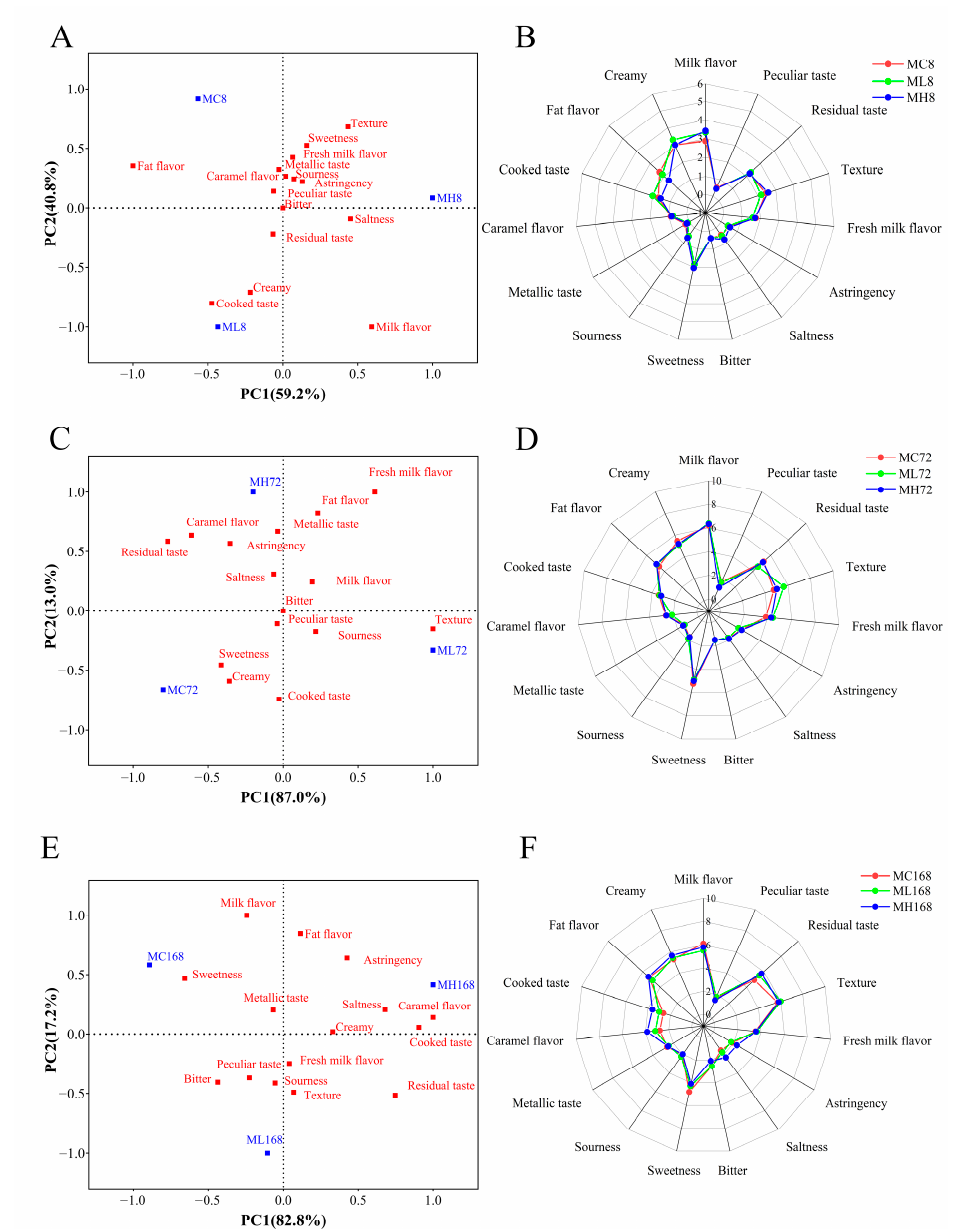
Figure 4. Principal component Analysis (PCA) diagram and spider web diagram of pasteurized milk. MC, 0-bar pressure-homogenized pasteurized milk; ML, 150-bar pressure-homogenized pasteurized milk; and MH, 300-bar pressure-homogenized pasteurized milk. PCA of 8-h samples ( A ). Cobweb plot of 8-h sample sensory attributes ( B ). PCA of 72-h samples ( C ). Cobweb plot of 72-h sample sensory attributes ( D ). PCA of 168-h samples ( E ). Cobweb plot of 168-h sample sensory attributes ( F ).